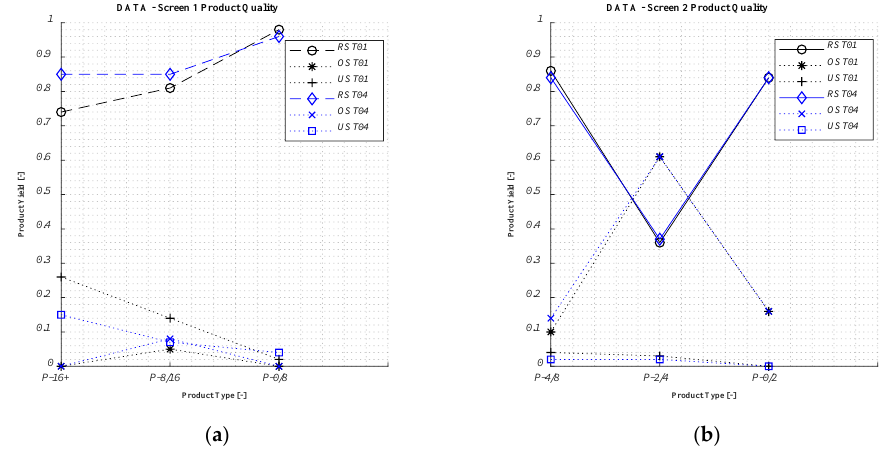
Figure 14. Screening partition curves for the two screens. ( a ) Screen 1 and ( b ) Screen 2.